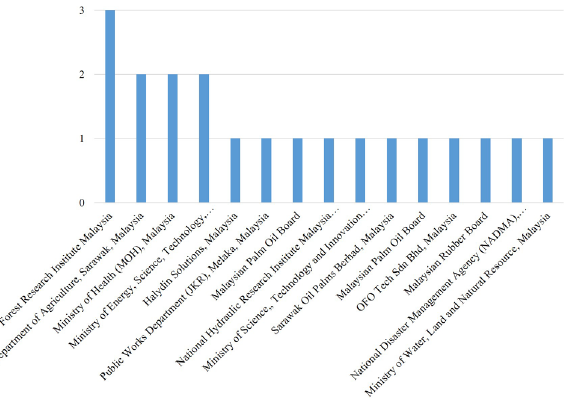
Figure 7. Affiliation appearance of local